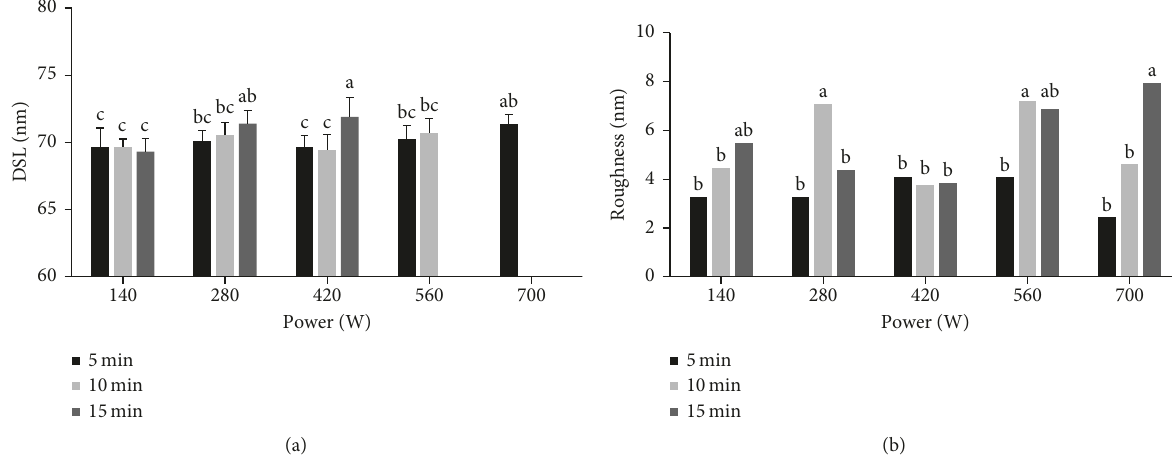
Figure 5: Changes of DSL (a) and roughness (b) of collagen fibrils under different microwave powers and times. a, b, and c values in the row and column; entries with the same superscript are not significantly different ( p ≥ 0 .